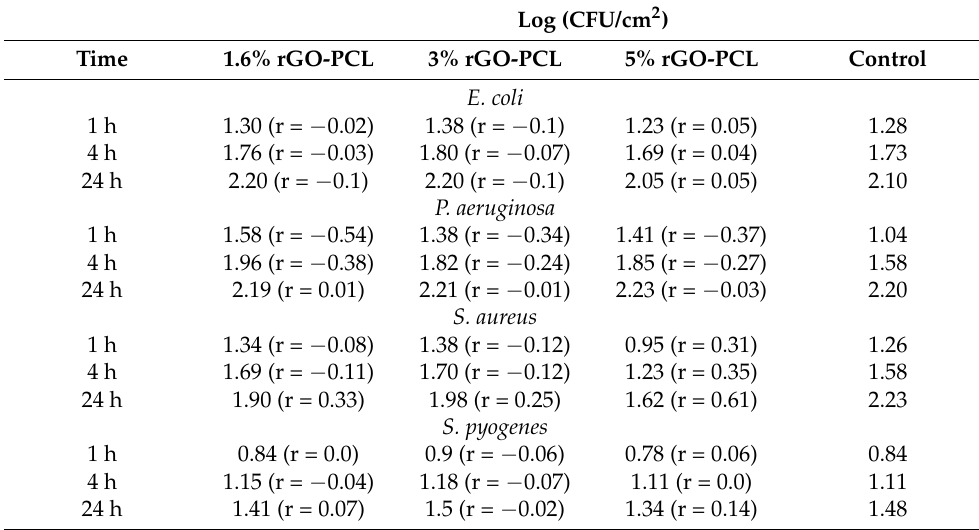
Table 1. Colony forming units (CFU) of E. coli , P. aeruginosa , S. aureus , and S. pyogenes after treatment with 1.6% rGO-PCL, 3% rGO-PCL, and 5% rGO-PCL for 1, 4, and 24 h.